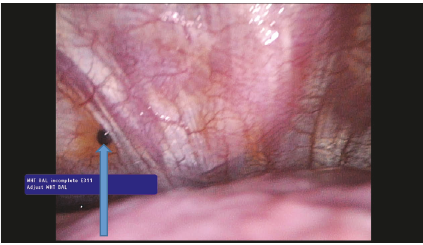
Figure 5: Blue arrow showing an endometrial implant on the chest